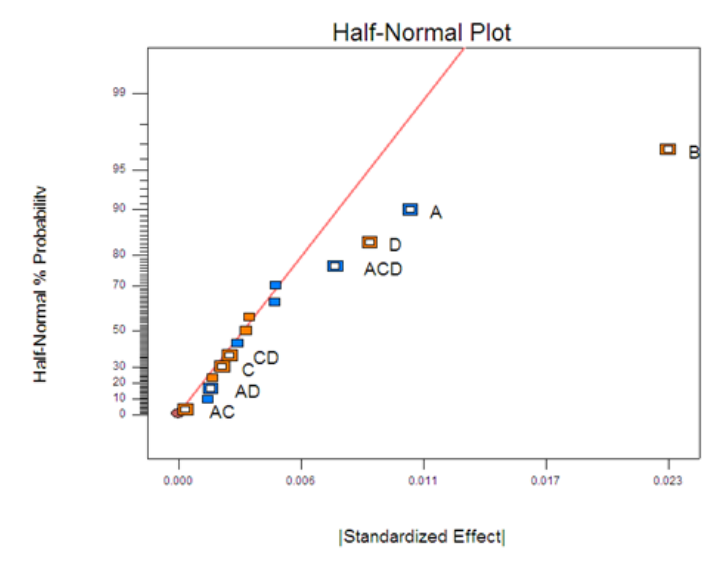
Figure 8. Half-normal probability plot of the medication delivery error effects